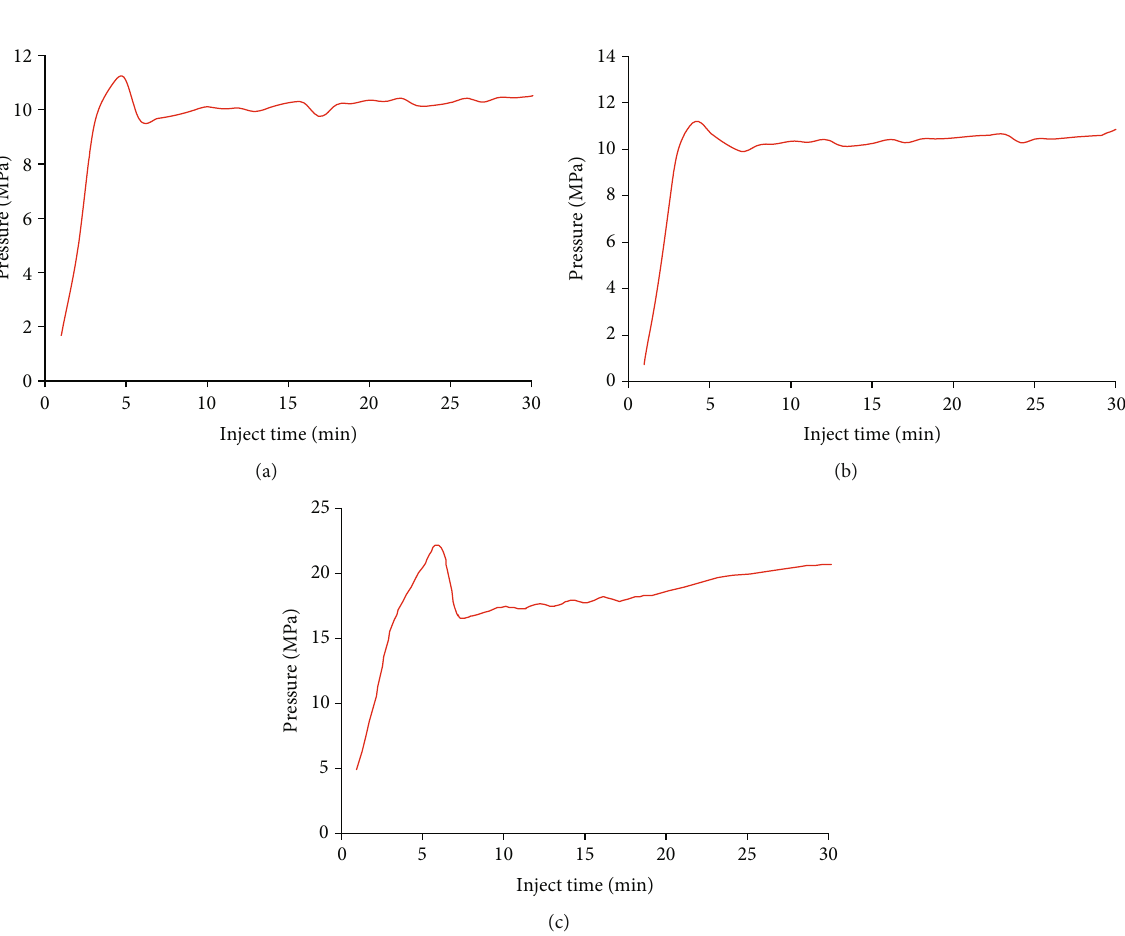
Figure 6: Changes in the injection pressure in samples 1 (a), 2 (b), and 3 (c) during hydraulic fracturing.